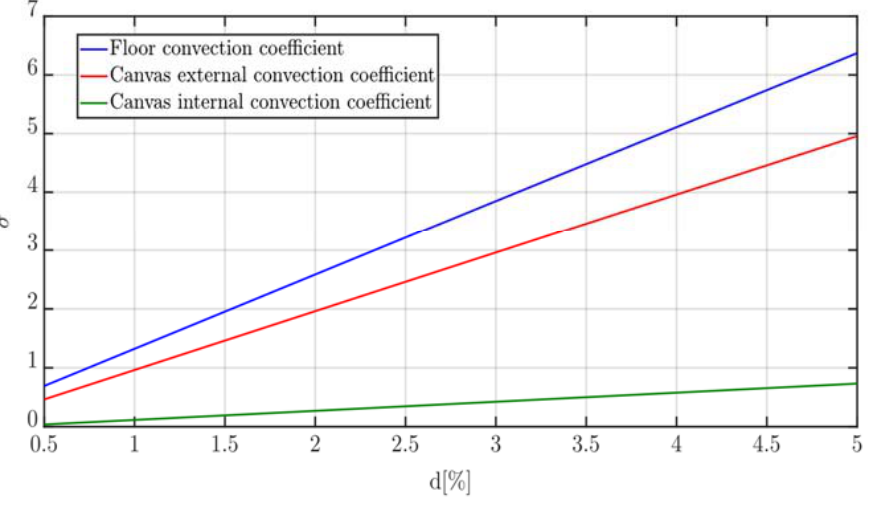
Figure 7. Result of the Monte Carlo sensitivity analysis for the convection coefficient in the canvas and the floor. The graph shows the dispersion obtained in the internal temperature ( σ ) versus the dispersion introduced in each parameter ( d ) .